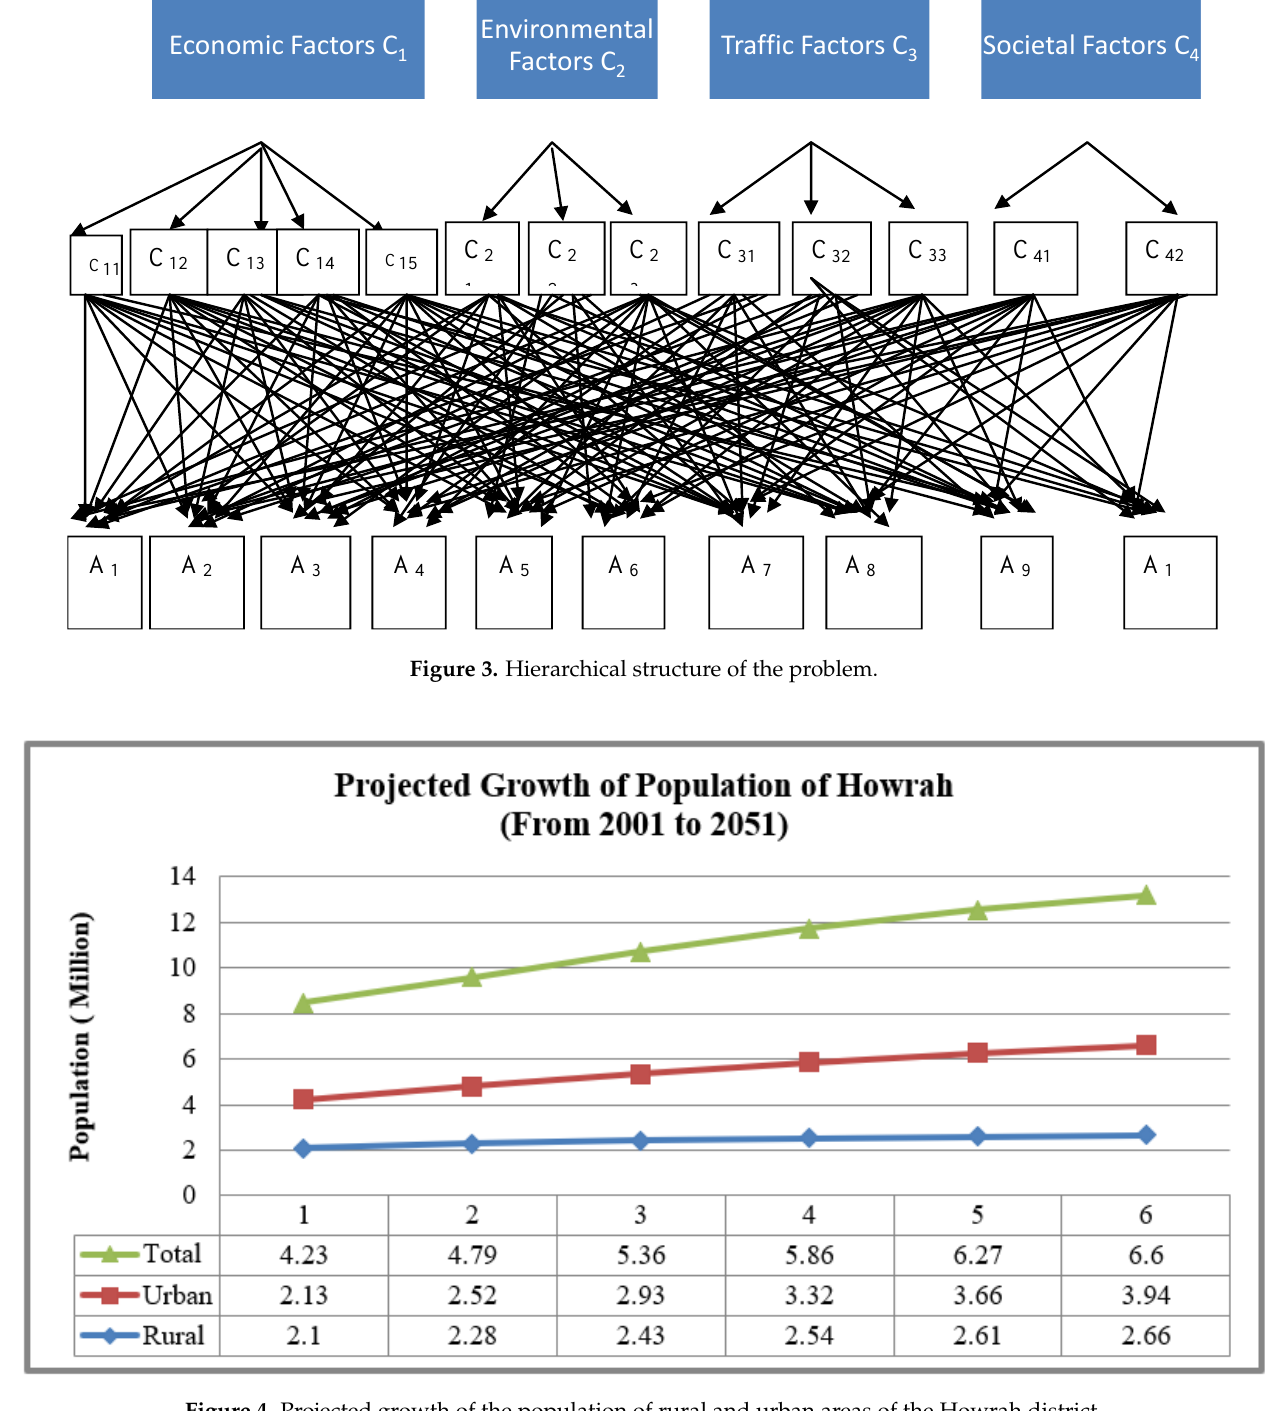
Figure 4. Projected growth of the population of rural and urban areas of the Howrah district. Urbanization is considered one of the most noteworthy anthropogenic inputs of the environmental framework, and thus the present study considered the spatio-temporal characteristics of urban growth and its inference in the transport of Howrah. The built-up land (Figure 5) has been generated using the NDBI (normalized difference built-up in- dex) with the following equation NDBI = MIR − (NIR/MIR) + NIR (Zha, 2003) [86]. Here, NIR is anear-infrared band such as ETM+ and TM, and LISSIII is a band no.4; MIR is a middle infrared band such as ETM+ and TM and LISSIII is a band no.5.The index is based on the unique spectral response of built-up lands that have a higher reflectance in the MIR wavelength range as compared to that in the NIR wave length range. Thereafter, the NDBI mapping has been prepared to understand the level of urbanization from 2000 (Figure 5a) to 2010 (Figure 5b) in the study area. It helps to correlate the changes in land use patterns and its consequences to the water storage of the study area. The NDBI values range from −1 to +1. Very low values of the NDBI (0.1 and below) correspond to non-urban features, while higher values indicate the covering of areas of impervious surfaces such as asphalt and concrete. To understand the levels of urbanization, the NDBI values have categorized into five zones, which range from −0.96 to 0.45 in 2000 and from –0.95 to 0.71 in 2010. The result with a negative value of NDBI represents the water bod- ies and vegetation covers, whereas the higher and positive values represent the build-up areas. The map of the year 2000 indicates a huge range of water bodies spread all over the district along with the two major rivers; the Rupnarayan River in west and south west and the Bhagirathi-Hooghly River in the east and south-east side. The major built-up areas are mostly concentrated over the north-east and north-west corners of the district covering the Bally-Jagacha and Udaynarayanpur blocks, respectively.